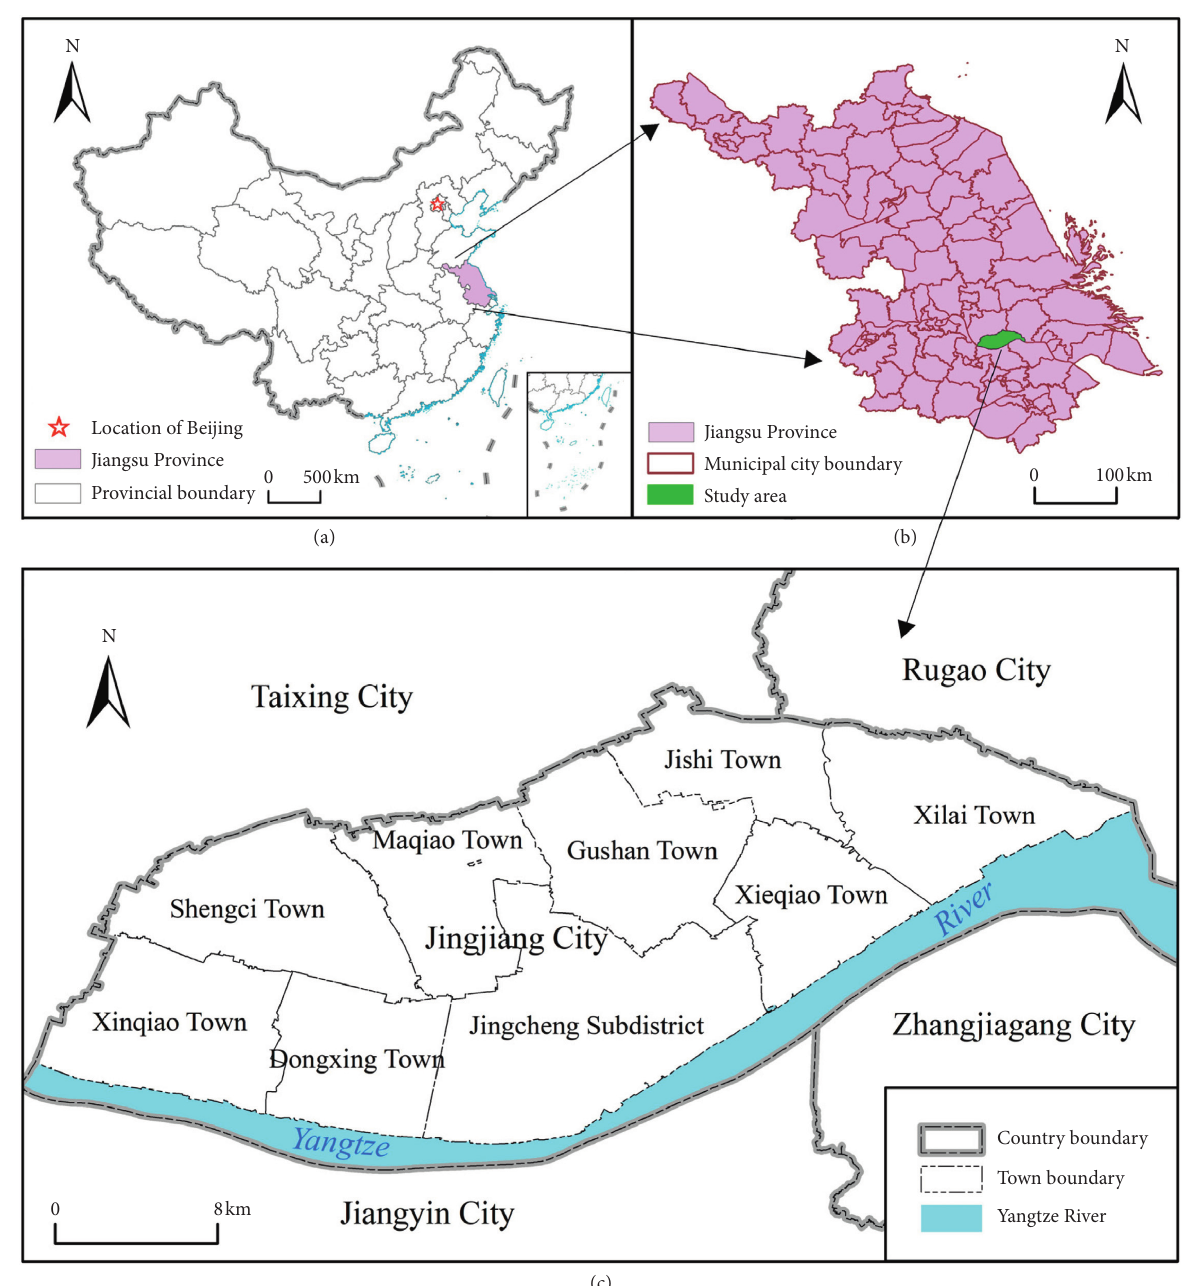
Figure 1: Study area: Jingjiang City, Jiangsu